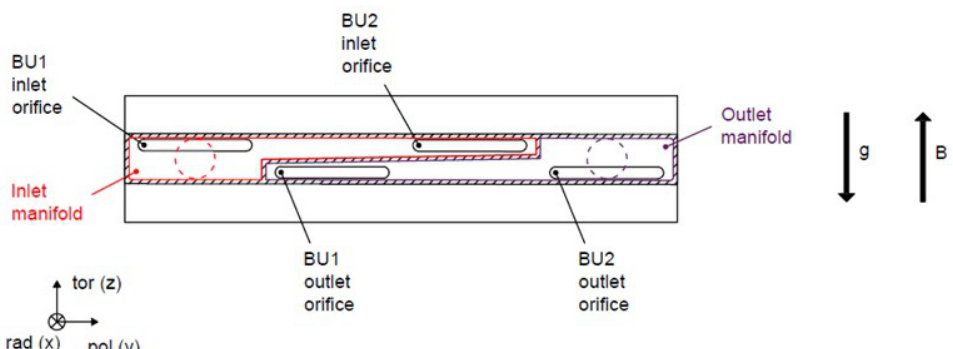
Figure 14. Toroidal-poloidal view of the mock-up. In red is outlined the feeding manifold, whereas in purple the collecting one. Cross-section shape of both inlet/outlet pipes and manifold/BU interface are